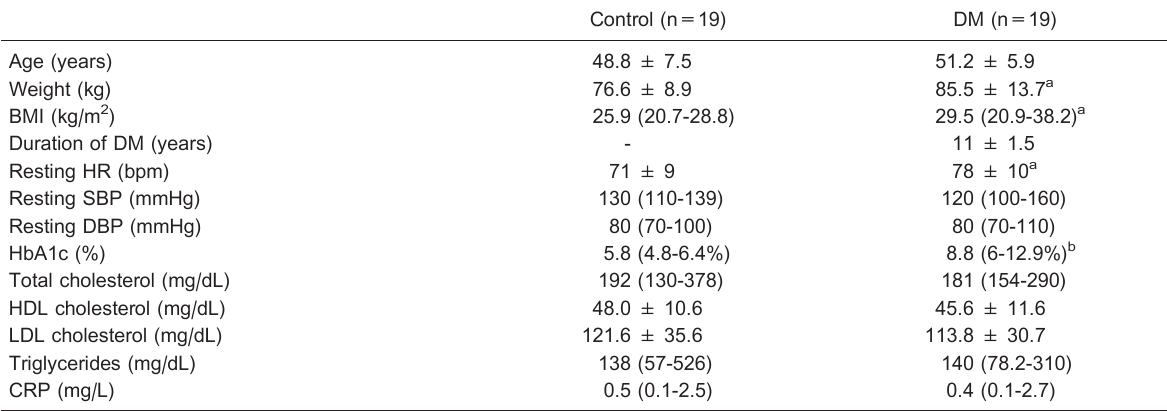
Table 1. Clinical and laboratory characteristics.